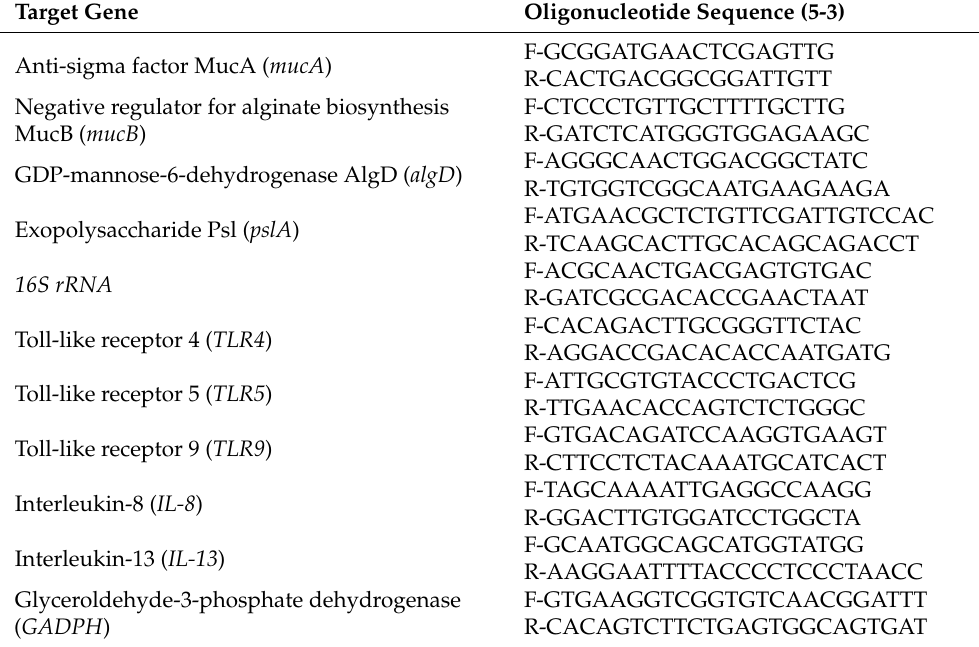
Table 1. Quantitative real-time PCR